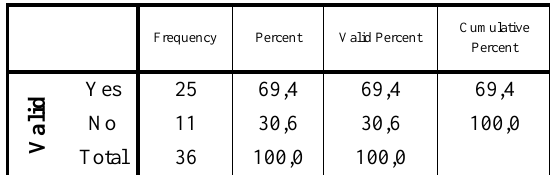
Table 12: Colleagues of Accounting Professionals who